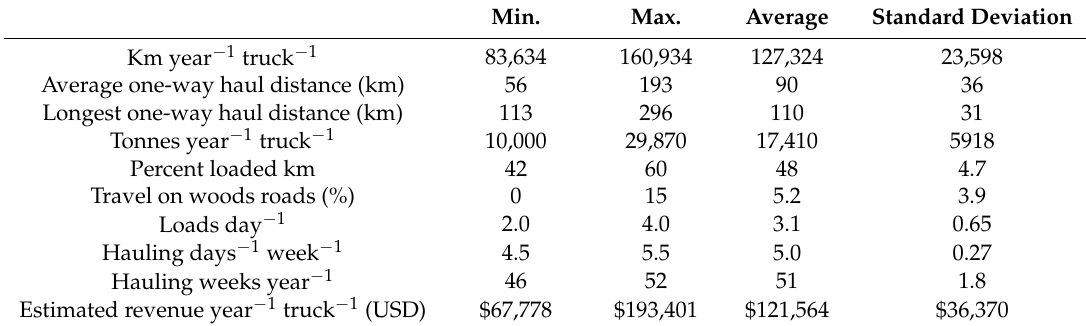
Table 2. Haul characteristics of eighteen log truck fleets in Georgia, U.S., 2017. Min.